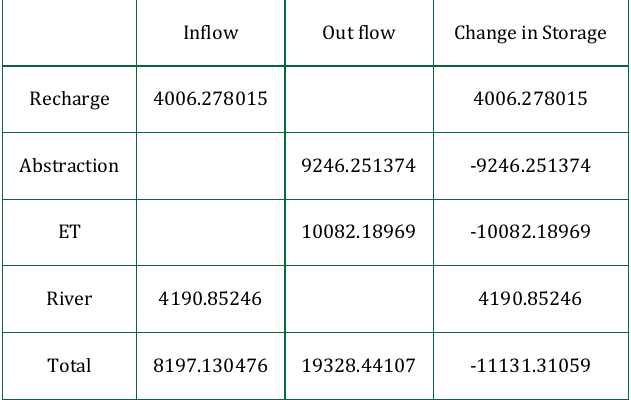
Table 4: Annual GW abstraction increased 10% with same Canal